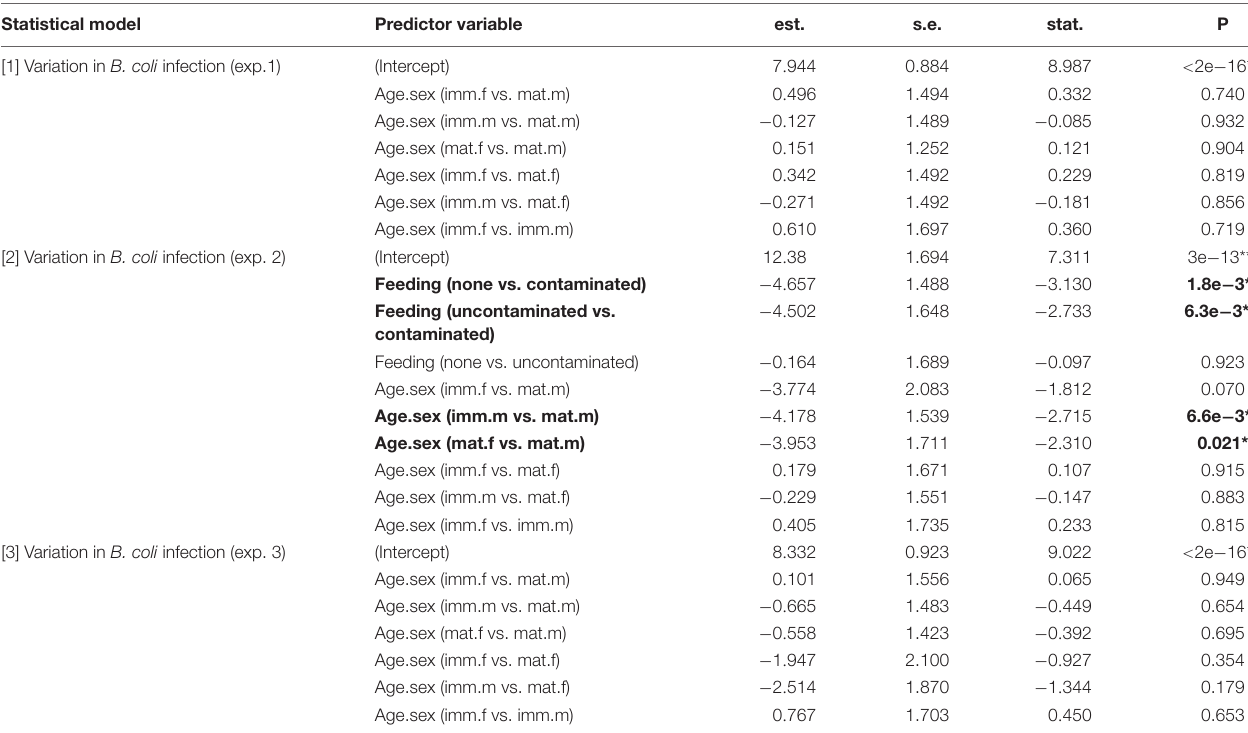
TABLE 1 | Factors affecting variation in levels of Balantioides coli infection (CPG). Statistical model Predictor variable